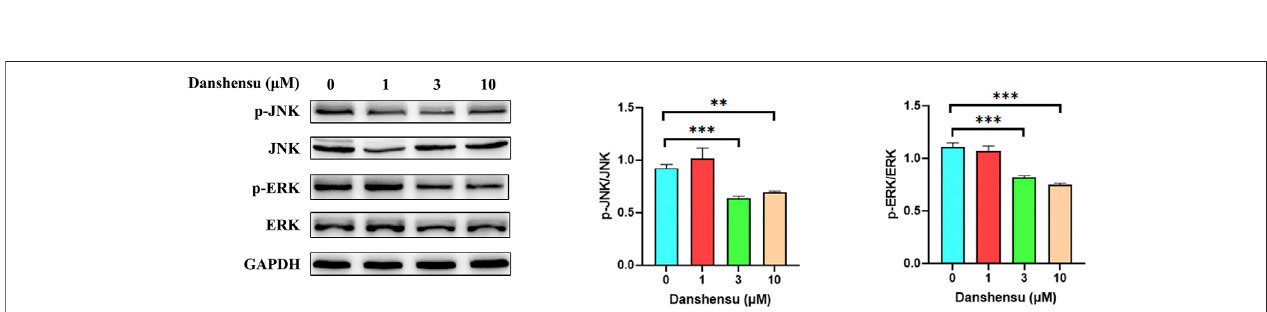
FIGURE10| DanshensusuppressesJNKandERKphosphorylationinAS fi broblasts.p-JNKandp-ERKproteinlevelsinAS fi broblaststreatedwithDanshensufor 14 days. ** p < 0.01, *** p < 0.001 vs. 0 group, n (cid:2) 3.